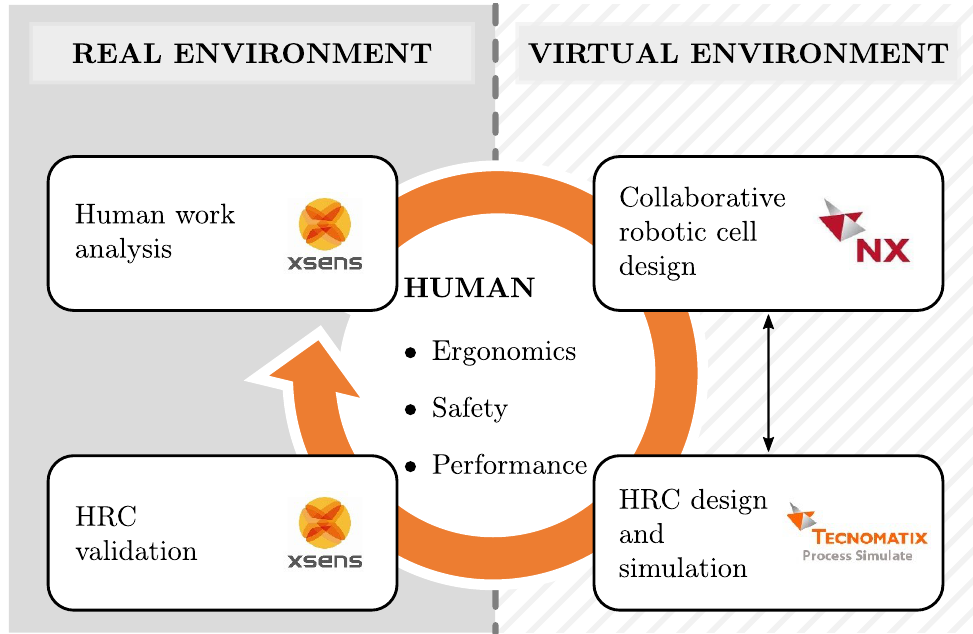
Figure 1. Simulation based method for human-oriented HRC